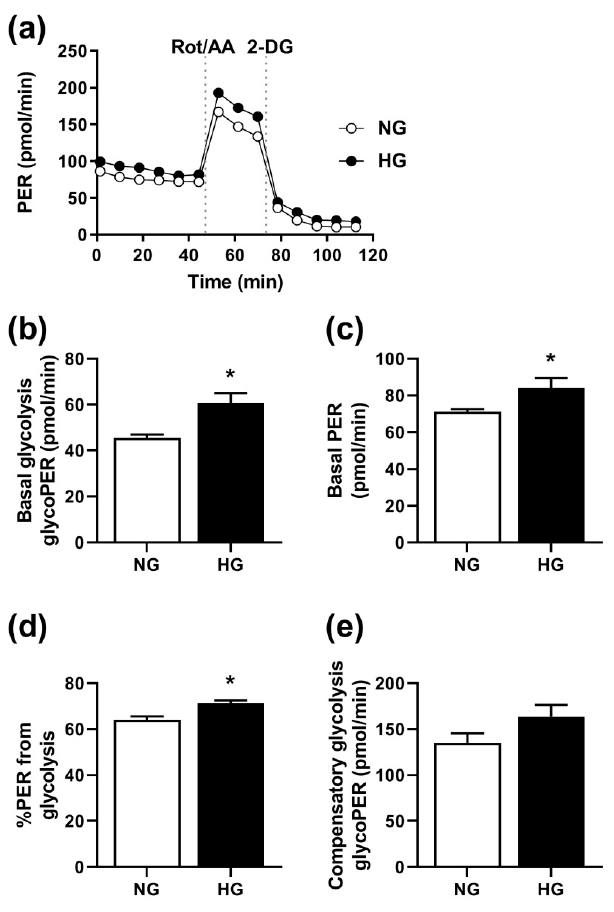
Figure 5. E ff ects of chronic hyperglycemia on the glycolytic rate. Human skeletal muscle cells were grown in 24-well Seahorse tissue culture plates, exposed to 20 mM glucose (HG) for the last four days of the differentiation period, or the standard differentiation medium (NG, 5.5 mM glucose), before measurement of the glycolytic rate with the Seahorse XF24e analyzer. Extracellular acidification rates and oxygen consumption rates were recorded six times at 6 min intervals at baseline, and following injections with 4 µM rotenone/antimycin A (Rot/AA) and 50 mM 2-deoxyglucose (2-DG), respectively. Proton efflux rate (PER), glycolytic proton efflux rate (glycoPER), basal glycolysis, basal PER, compensatory glycolysis, and post 2-DOG acidification were calculated as described in Section 2.6. ( a ) One representative experiment. ( b – e ) Mean ± SEM from five individual experiments (n = 5). ( b ): basal glycolysis glycoPER in pmol / min, ( c ): basal PER in pmol / min, ( d ): percentage PER from glycolysis, and ( e ): compensatory glycolysis glycoPER in pmol / min. * Statistically significant vs. NG ( p < 0.05, unpaired Student’s t